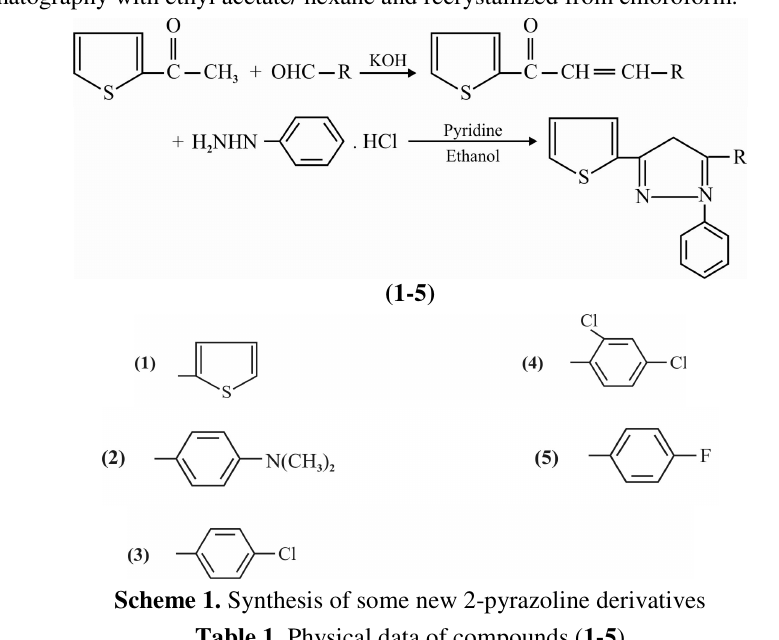
Table 1. Physical data of compounds ( 1-5 )